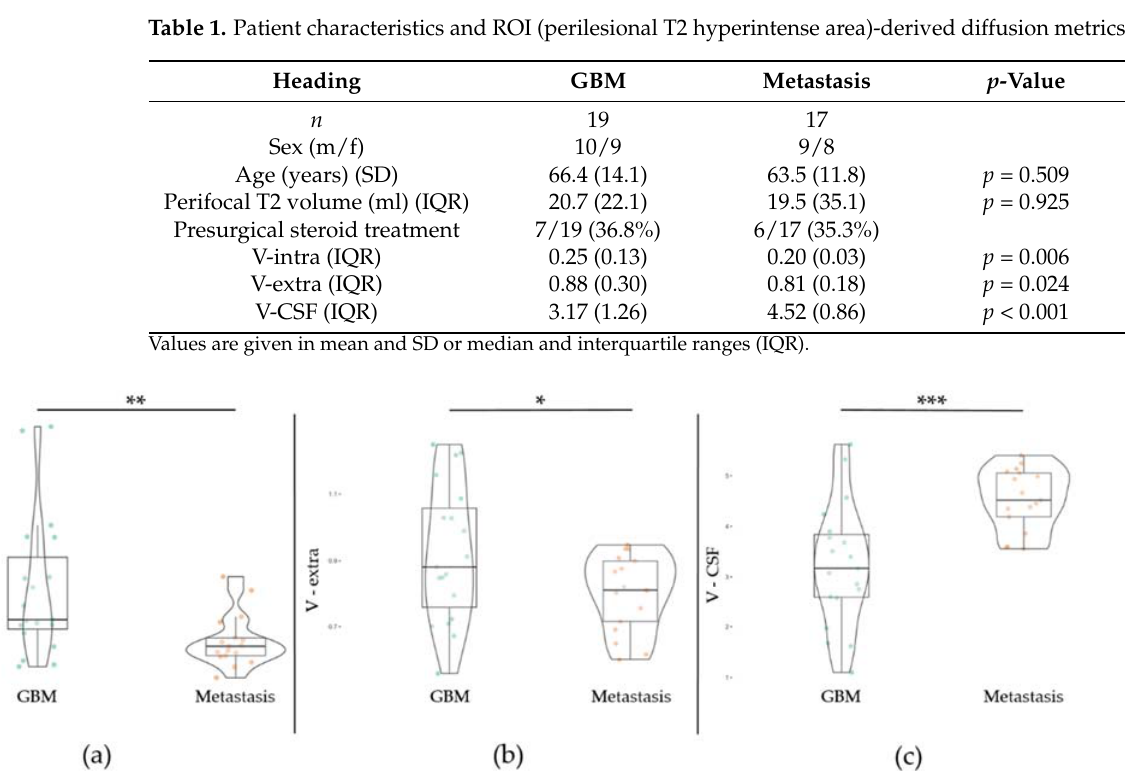
Figure 3. Axial FLAIR ( a , c ) and parametric V-CSF-maps ( b , d ) in a left centroparietal GBM ( a , b ) and left frontal metastasis ( c , d ). Of note, the metastasis shows a relative increase in perilesional V-CSF compared with GBM ( d , b ). Table 1. Patient characteristics and ROI (perilesional T2 hyperintense area)-derived diffusion metrics.